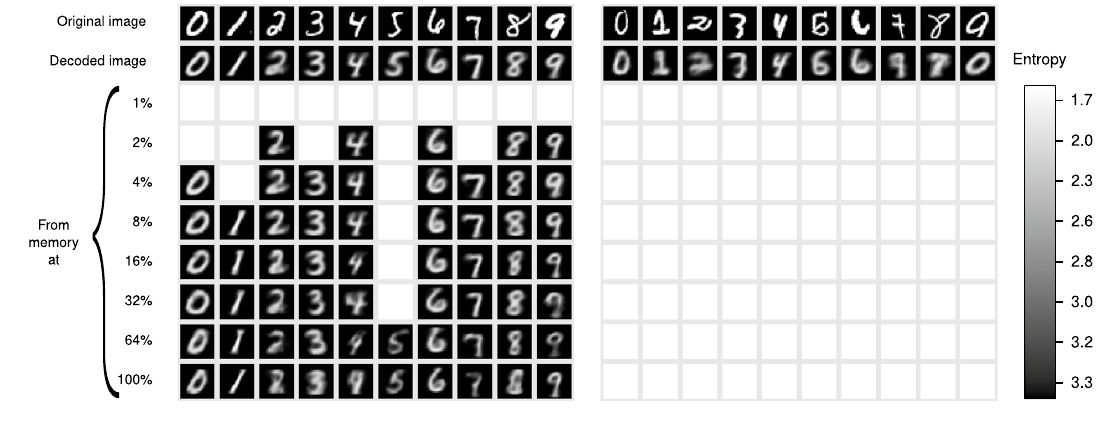
Figure 7. Memory recovery with